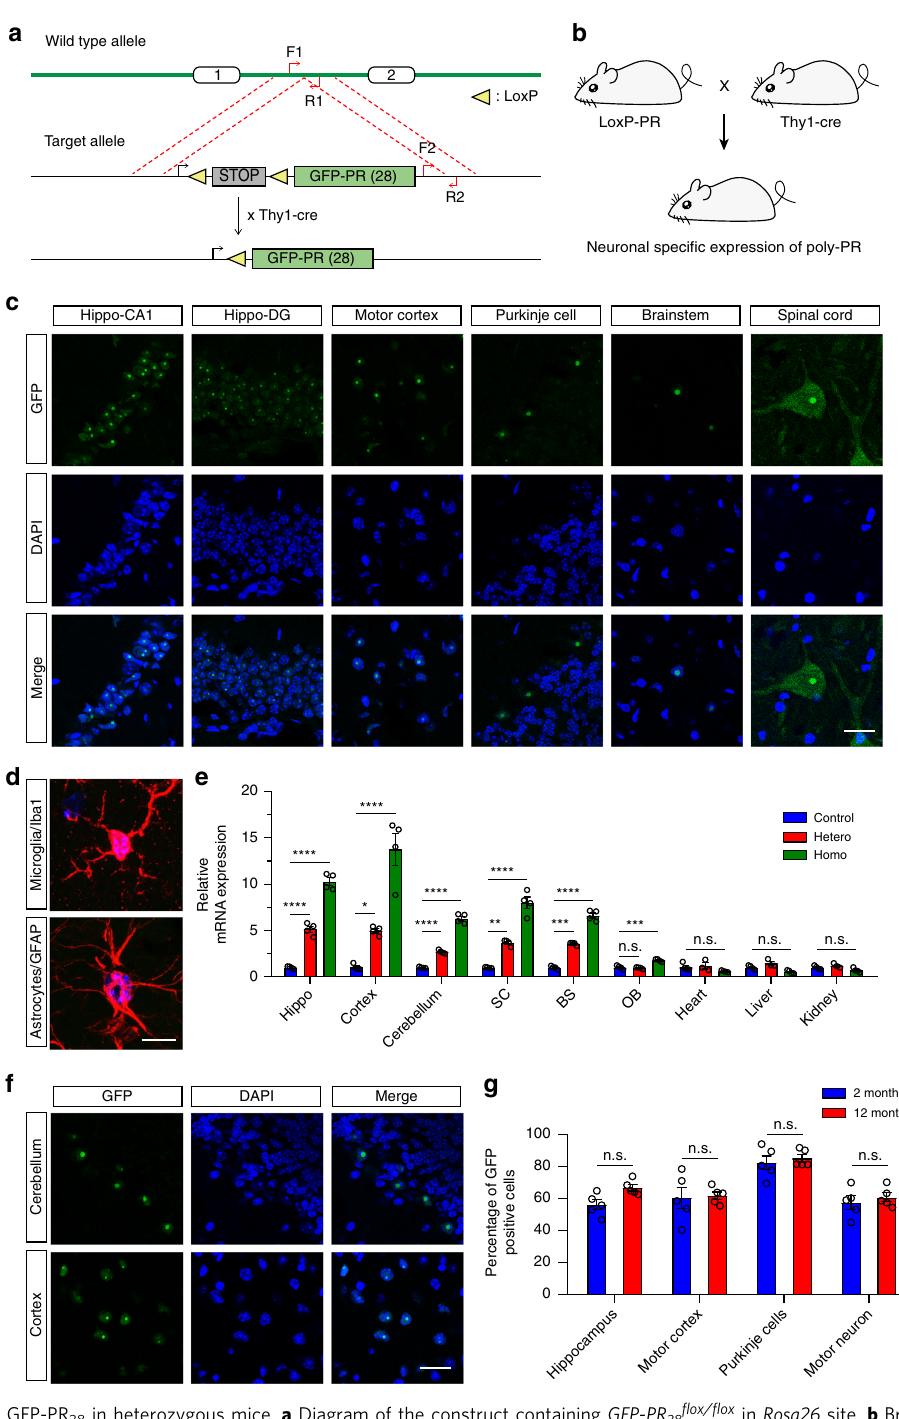
Fig. 1 Distribution of GFP-PR 28 in heterozygous mice. a Diagram of the construct containing GFP-PR 28 fl ox/ fl ox in Rosa26 site. b Breeding scheme for producing GFP-PR 28 fl ox/ + ;Thy1-Cre + heterozygous mice driven by Thy1 promoter for neuronal expressions. c Representative images showing distribution of poly-PR aggregates in different brain regions of GFP-PR 28 heterozygous mice at 2 months of age. GFP (green), Hoechst (blue). Scale bar represents 50 μ m. d Representative images showing the distribution of GFP-PR 28 in GFAP or Iba1-positive glia in the motor cortex of 6-month-old GFP-PR 28 heterozygous mice. GFP (green), Hoechst (Blue), GFAP/Iba1 (Red). Scale bar represents 10 μ m. e Relative mRNA levels of GFP in different brain regions and tissues of 20-day-old control, GFP-PR 28 heterozygous and homozygous mice. Hippocampus (Hippo), spinal cord (SC), brainstem (BS), olfactory bulb (OB). One-way ANOVA, Bonferroni post hoc test; n = 3 – 4 mice per group. f Representative images showing the distribution of poly-PR aggregates in the cerebellum and motor cortex of GFP-PR 28 heterozygous mice at 12 months of age. GFP (green), Hoechst (Blue). Scale bar represents 50 μ m. g Percentage of cells containing GFP-PR 28 in different brain regions of GFP-PR 28 heterozygous mice at 2 and 12 months of age. Two-way ANOVA, Bonferroni post hoc test; n = 5 mice per group. All data were displayed as mean ± s.e.m. * P < 0.05, ** P < 0.01, *** P < 0.001, **** P < 0.0001, n.s. not signi fi